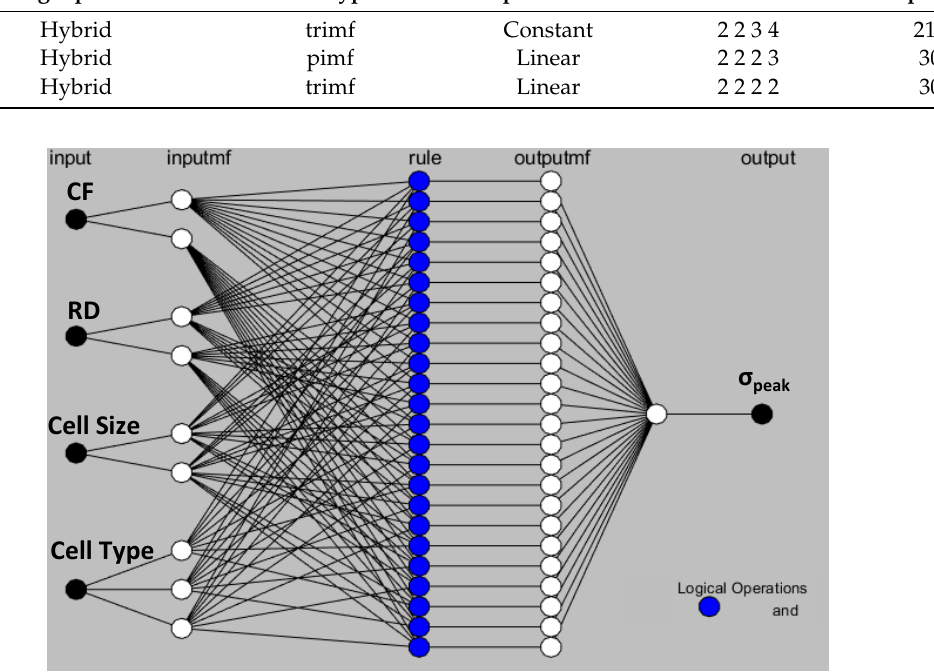
Figure 15. ANFIS structure network for modeling the σ peak with “2 2 2 3” number of